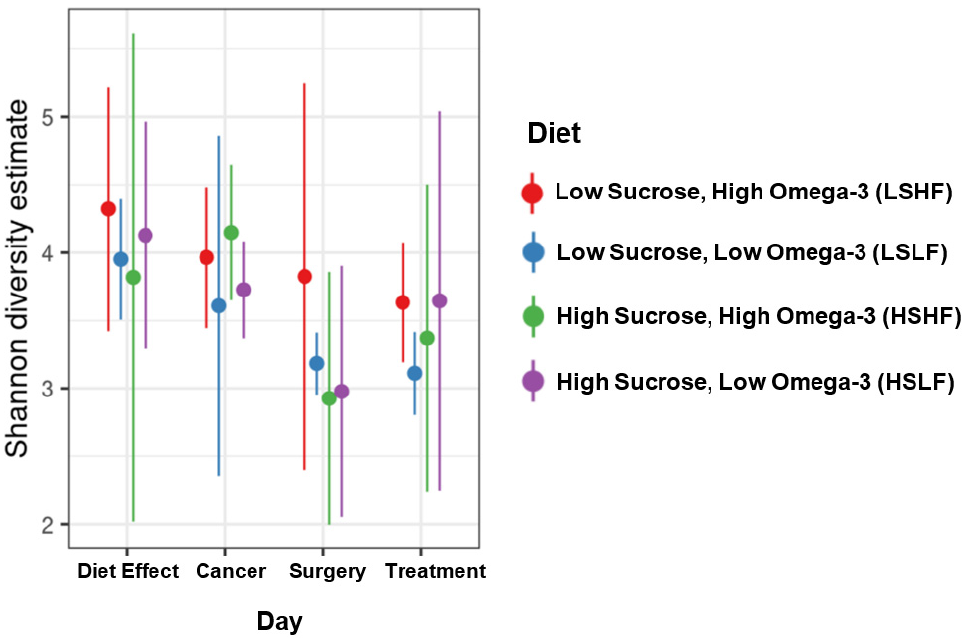
Figure 3. Richness and evenness of ASV/per-sample, weighted by the Shannon diversity index, demonstrate differences in alpha-diversity modeled by day and diet.